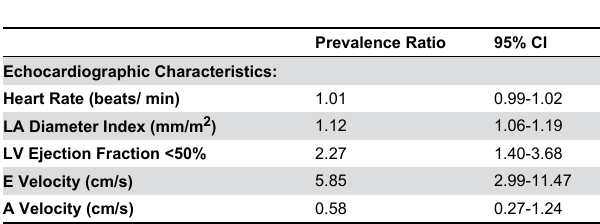
Table S1. Characteristics of Participants with or without Tricuspid Regurgitant Velocity